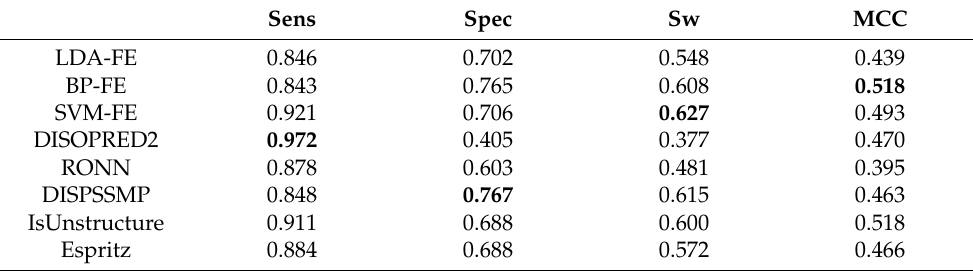
Table 7. Prediction performance comparison based on test set R80.